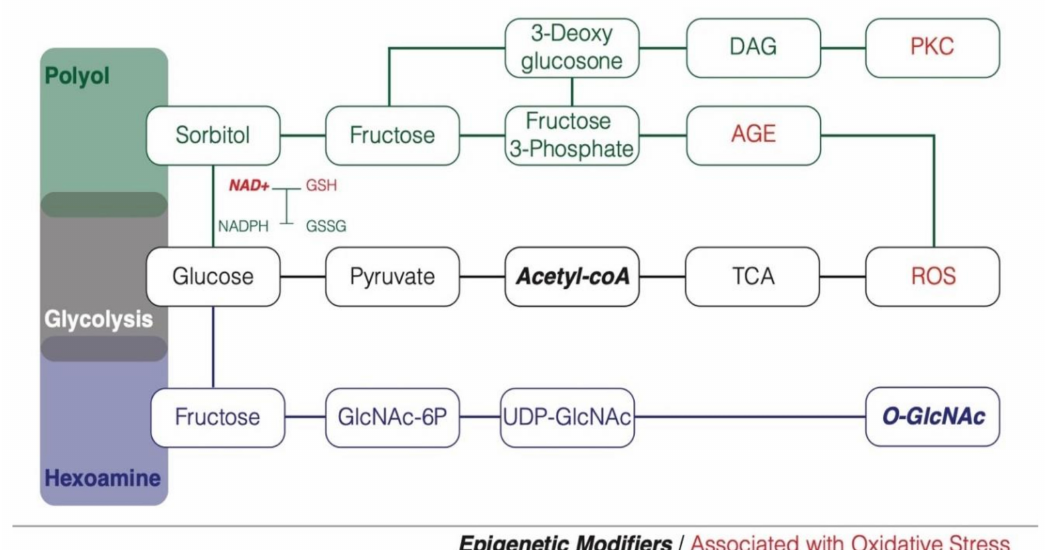
Figure 1. Pathways involved in Glucose metabolism with influences on oxidative stress. The Polyol and Hexoamine pathways are recruited when glucose rises to compensate the Glycolysis pathway. The activation of Polyol and Hexoamine pathways participate to the cellular glucotoxicity by increasing the production of oxidative stress associated molecules (in red). The increase of glucose metabolism also leads to an increase of epigenetic modifiers (in bold italic). Such factors may explain the association between high-glucose exposure and increased metabolic sensitivity. DAG: diacylglycerol; PKC: protein kinase C; AGE: advanced glycation end-products; NAD: nicotinamide adenine dinucleotide; NADPH: nicotinamide adenine dinucleotide phosphate; GSH: glutathione; GSSG: glutathione disulfide; TCA: tricarboxylic acid cycle; ROS: reactive oxygen species; GlcNAc-6P: N-acetylglucosamine-6-phosphate; O-GlcNAc: O-Linked β